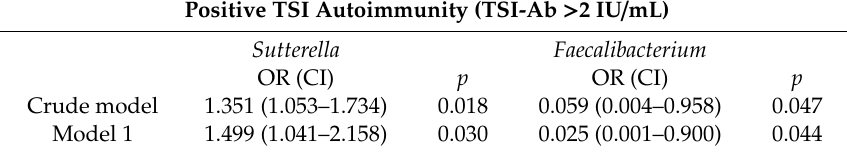
Table 4. Adjusted model for autoimmunity thyroid profile (Positive TSI-Ab > 2 IU / mL)—Gut microbiota